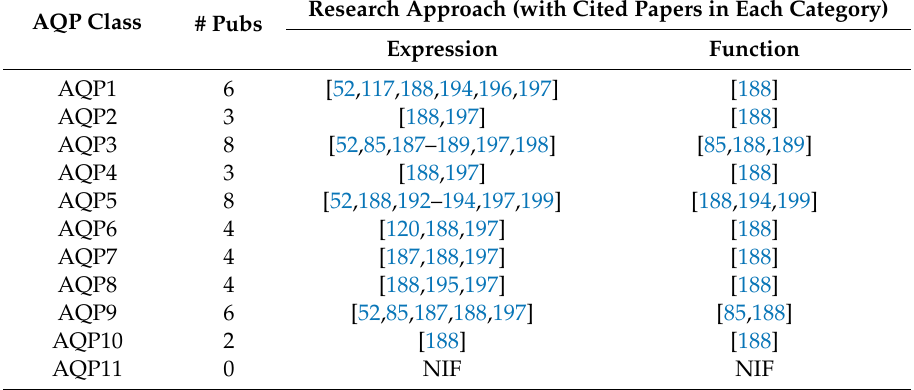
Table 6. Publications on AQPs in ovarian cancer, classified by research approach. Research Approach (with Cited Papers in Each Category) AQP Class # Pubs Expression Function